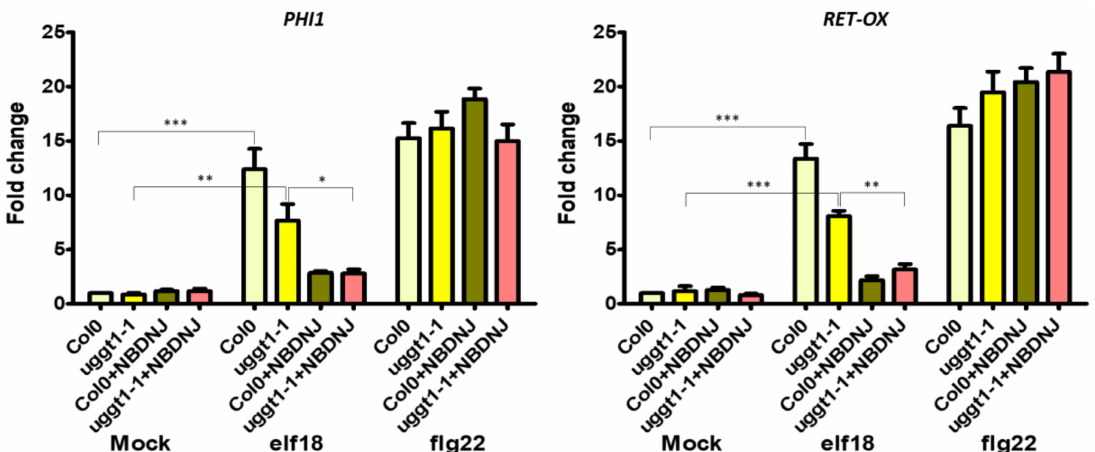
Figure 5. Expression of defence genes in the At uggt1-1 plant. 10-day-old seedlings were treated with water or elf18 and flg22 elicitors, with and without 70 µ M N B-DNJ. Expression of PHI1 and RET-OX genes were determined by qRT-PCR 30 min after treatment. Transcript levels are shown as the mean of at least three independent experiments ( ± s.e. n = 20 in each experiment) normalized to UBQ5 (ubiquitin 5) used as a reference. In both panels, asterisks indicate statistically significant differences among mock and treatments within the same genotype (same color) according to Student’s t -test (* = p < 0.5, ** = p < 0.01, *** = p <